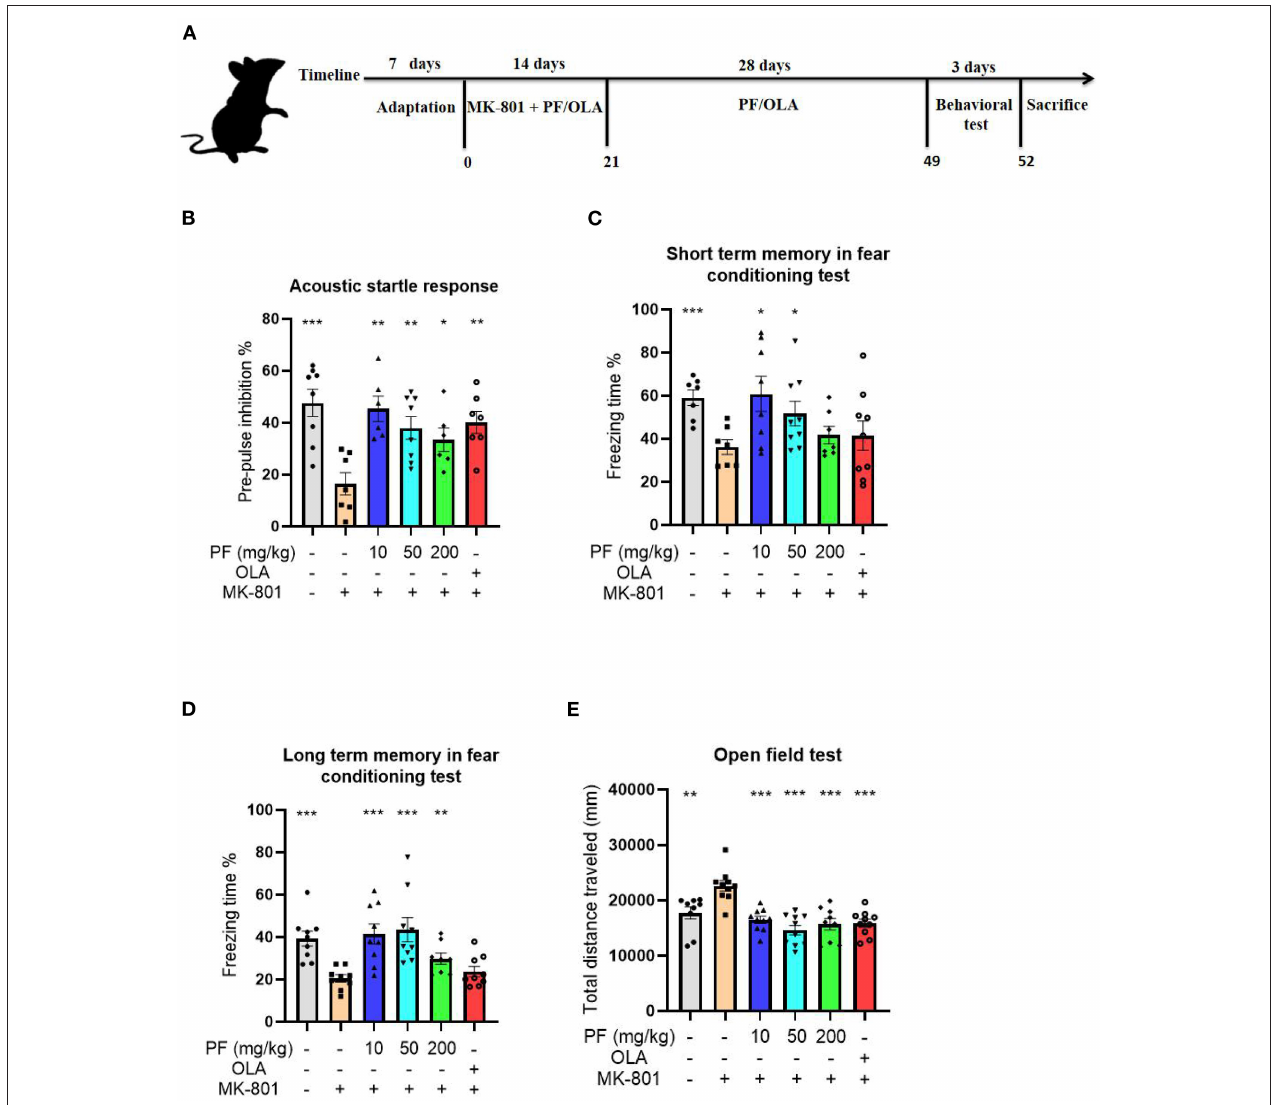
FIGURE 1 | Paeoniflorin (PF) rescued MK-801 induced schizophrenia–like behaviors in mice. (A) Schematic representation of experimental design for the MK-801-induced schizophrenia model. (B) The PPI deficits observed in the model mice were significantly reversed by PF treatment, and the effects were comparable with the first-line antipsychotics olanzapine on the model mice. (C) PF treatment significantly rescued the memory deficits in the MK-801-treated mice. (D) The impaired long-term memory in the model mice were significantly improved by treatment of PF. (E) The open field test demonstrated that the hyperactivities of the schizophrenia model mice were significantly inhibited by the administration of PF. Additionally, olanzapine also inhibited the hyperactivities of the MK-801-treated mice. Three-way ANOVA statistics: F B = 5.749, P < 0.001; F C = 2.905, P = 0.025; F D = 6.855, P < 0.001; F E = 10.87, P < 0.001. Values are the mean ± SEM, n = 7–10/group. * p < 0.05, ** p < 0.01, *** p <